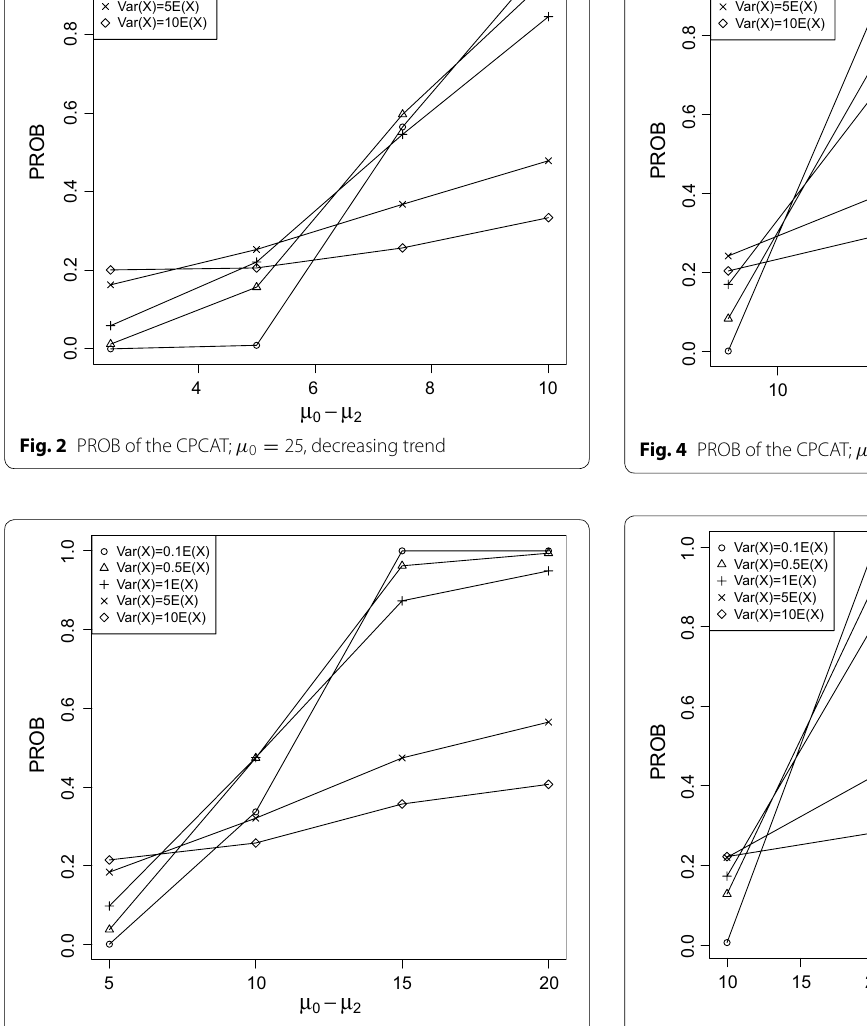
Fig. 3 PROB of the CPCAT; µ 0 = 50 , decreasing trend